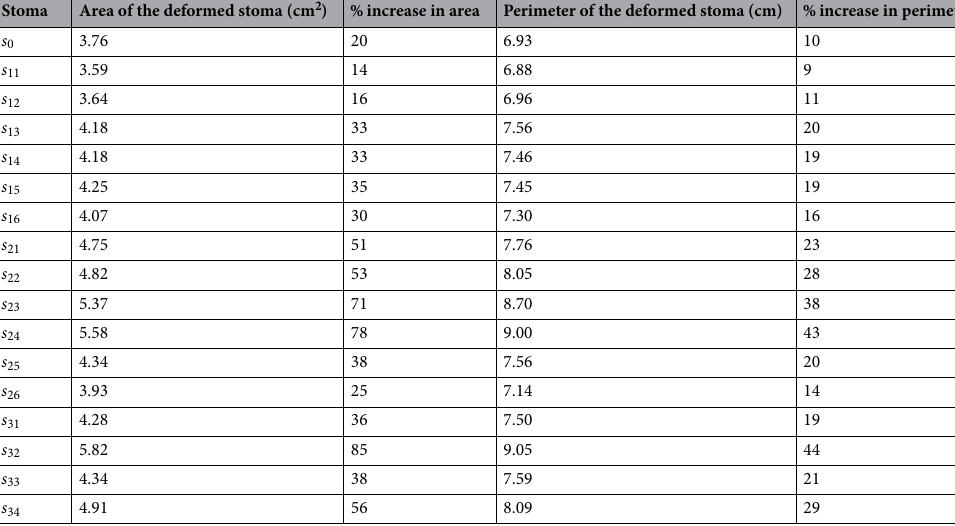
Table 2. Area and perimeter of stomas in the deformed geometry when an intraabdominal pressure of P = 20 kPa is applied. The percentage of increase with respect to the undeformed geometry is also included. Note that in the undeformed geometry the diameter of the stoma is 2 cm, the area is therefore 3.14 cm perimeter is 6.28 cm. In all cases, the dimensions of the deformed trephines were measured at the innermost surface of the abodminal